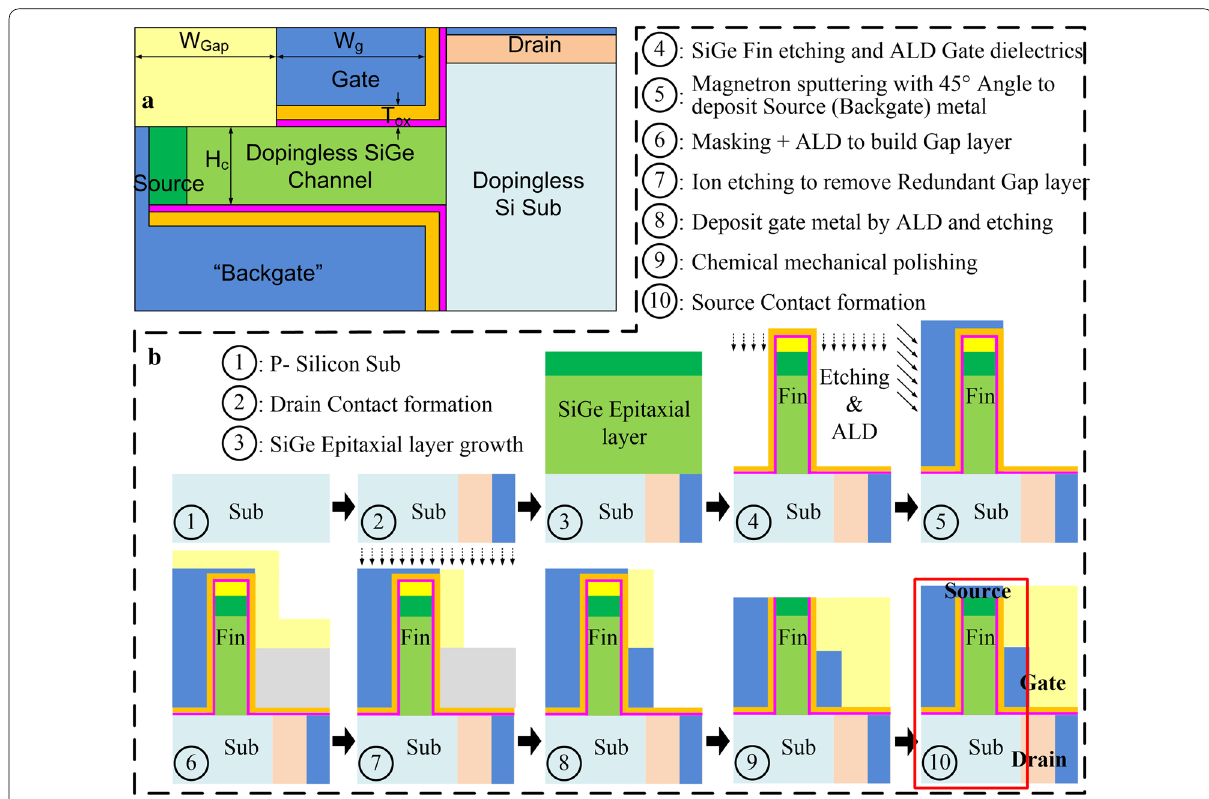
Fig. 1 a Structure and b fabrication flow of DF-TFET